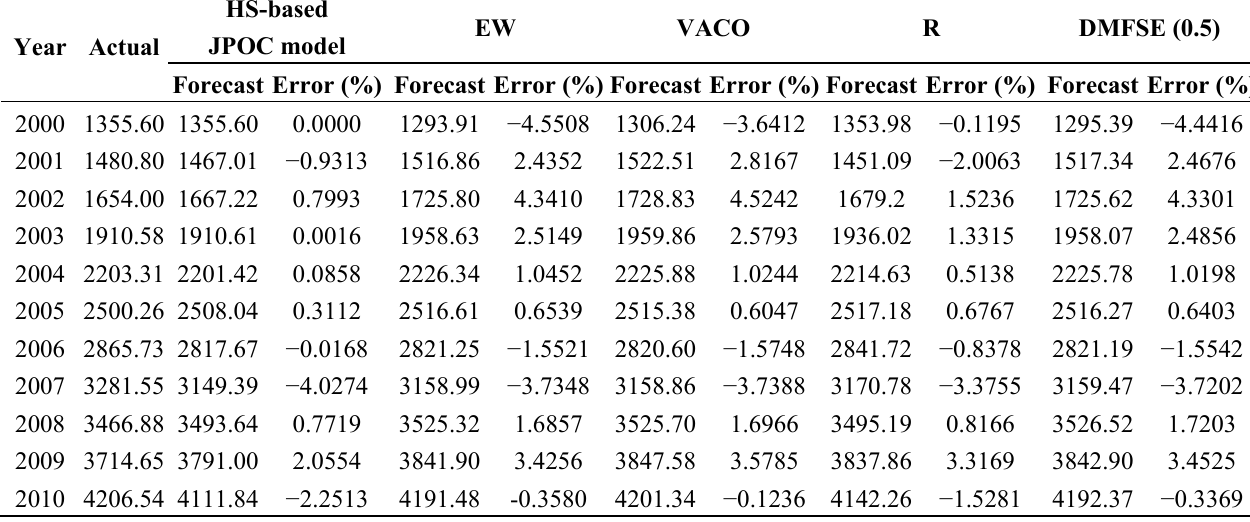
Table 8. Forecasting results of HS based JPOC model and other combination models for China